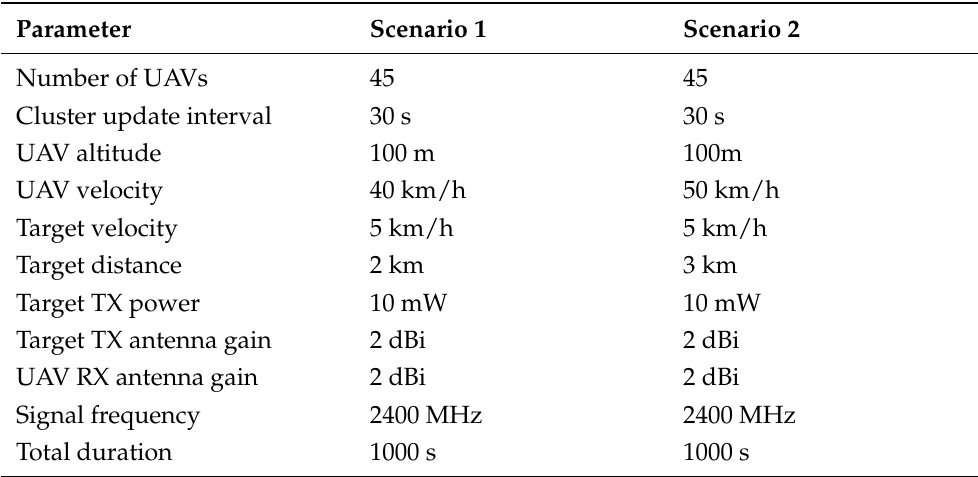
Table 1. Parameters of the simulation for each examined scenario. The two scenarios are differentiated in terms of the UAVs’ velocity and the target’s initial distance.